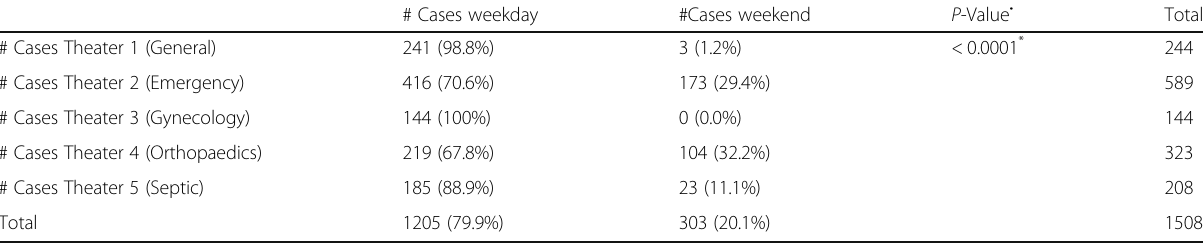
Table 2 Five-month procedure volume analysis